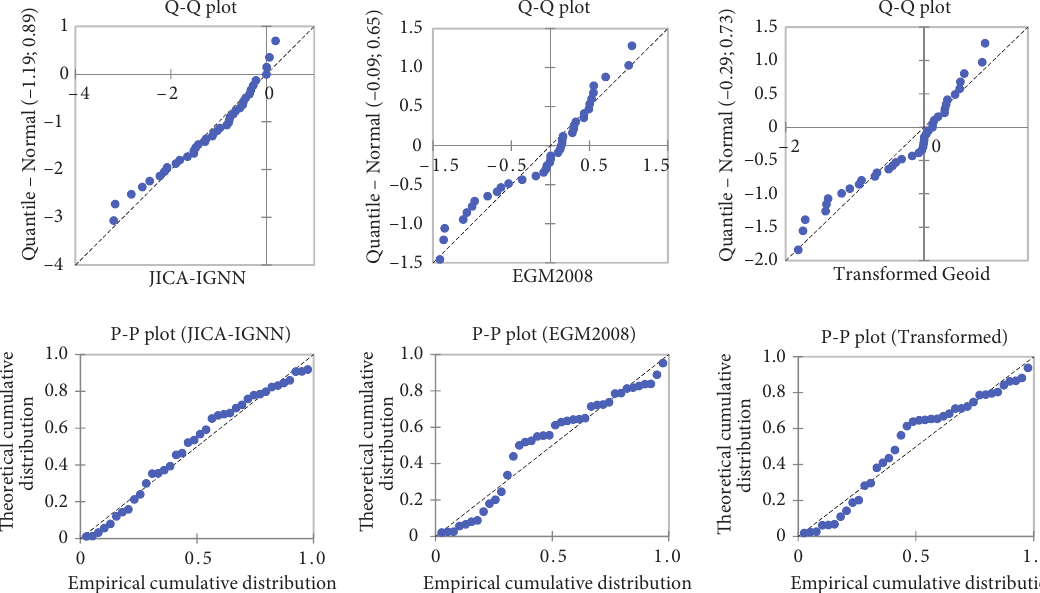
Fig. 12. Normal Quantile-Quantile, Probability-Probability